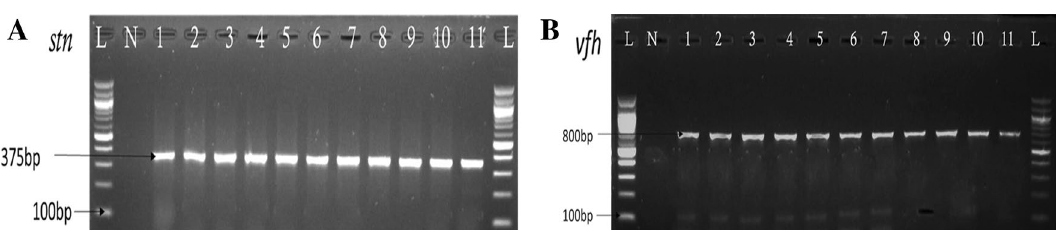
Figure 4. Gel picture representing molecular characterisation of virulence toxins. ( A ) ( stn virulence toxins) Lane 1–11 positive, ( B ) ( vfh virulence toxins) Lane 1–11 positive. Lane L: Molecular Marker (100 bp); Lane N: Negative